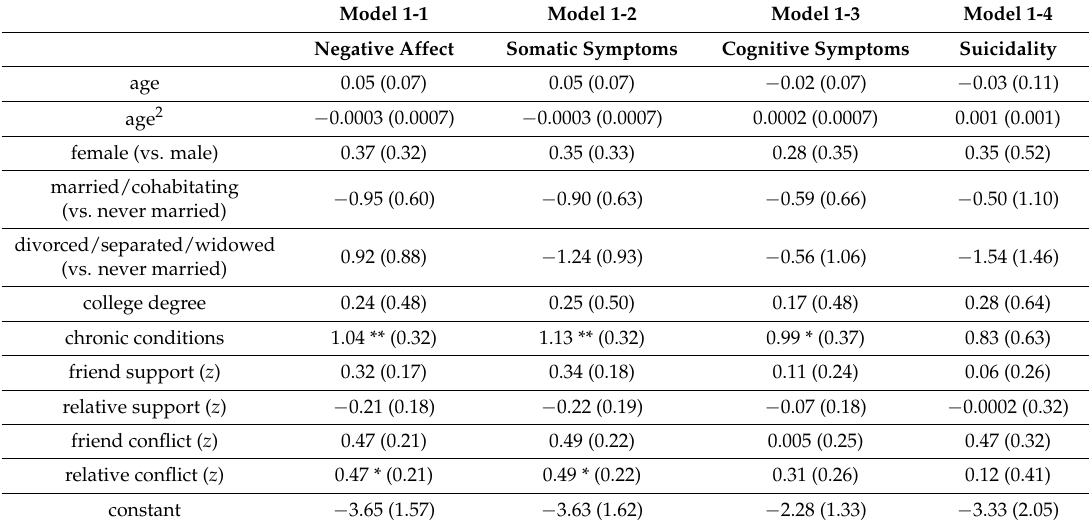
Table 6. Weighted Logistic Regression on Four Dimensions of Depression Among Foreign-born Chinese